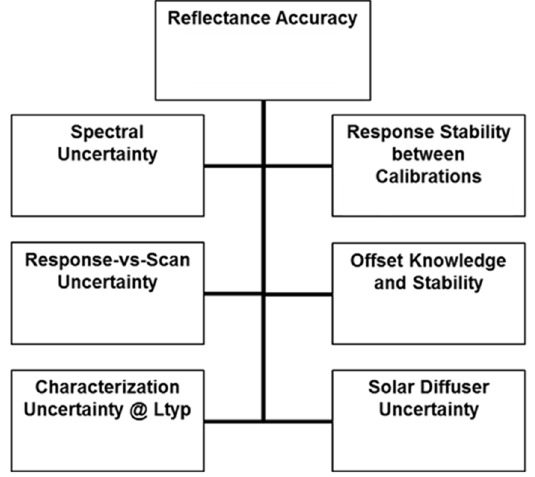
Figure 22. VIIRS top-level radiometric calibration uncertainty tree. Table 6. A breakout of the reflective solar band calibration uncertainty tree for each component and a total rollup (highlighted in green for pass and red for fail). Band M11 fails due to high uncertainty in the SD BRF characterization.